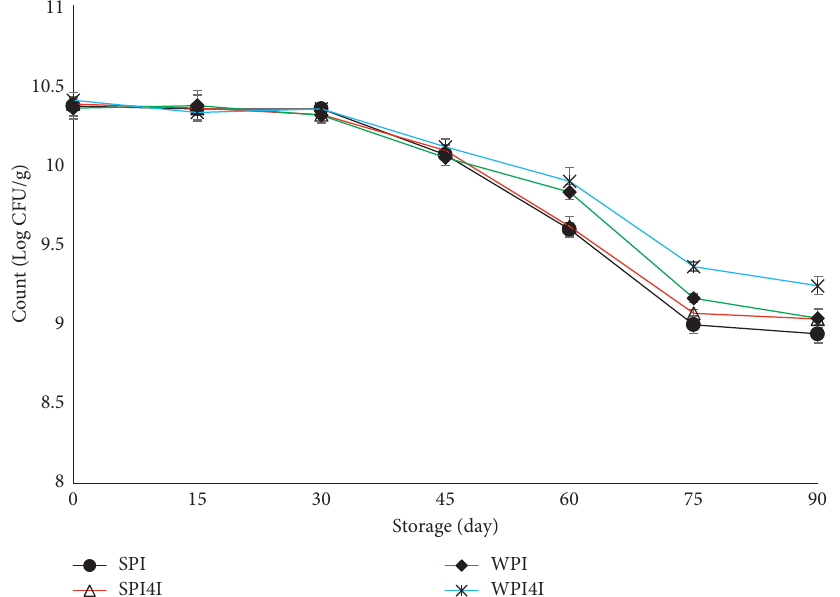
Figure 9: Viability of L. reuteri encapsulated within different wall materials during storage; SPI (soy protein isolate 20%), SPI4I (soy protein isolate 20%+inulin 4%), WPI (whey protein isolate 20%), WPI4I (whey protein isolate 20% +inulin 4%), and C (free bacteria).